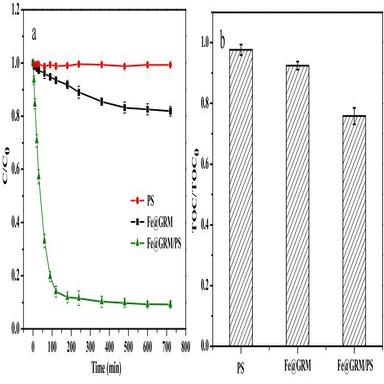
The effect of different processes of AO7 removal (a) and TOC removal (b).